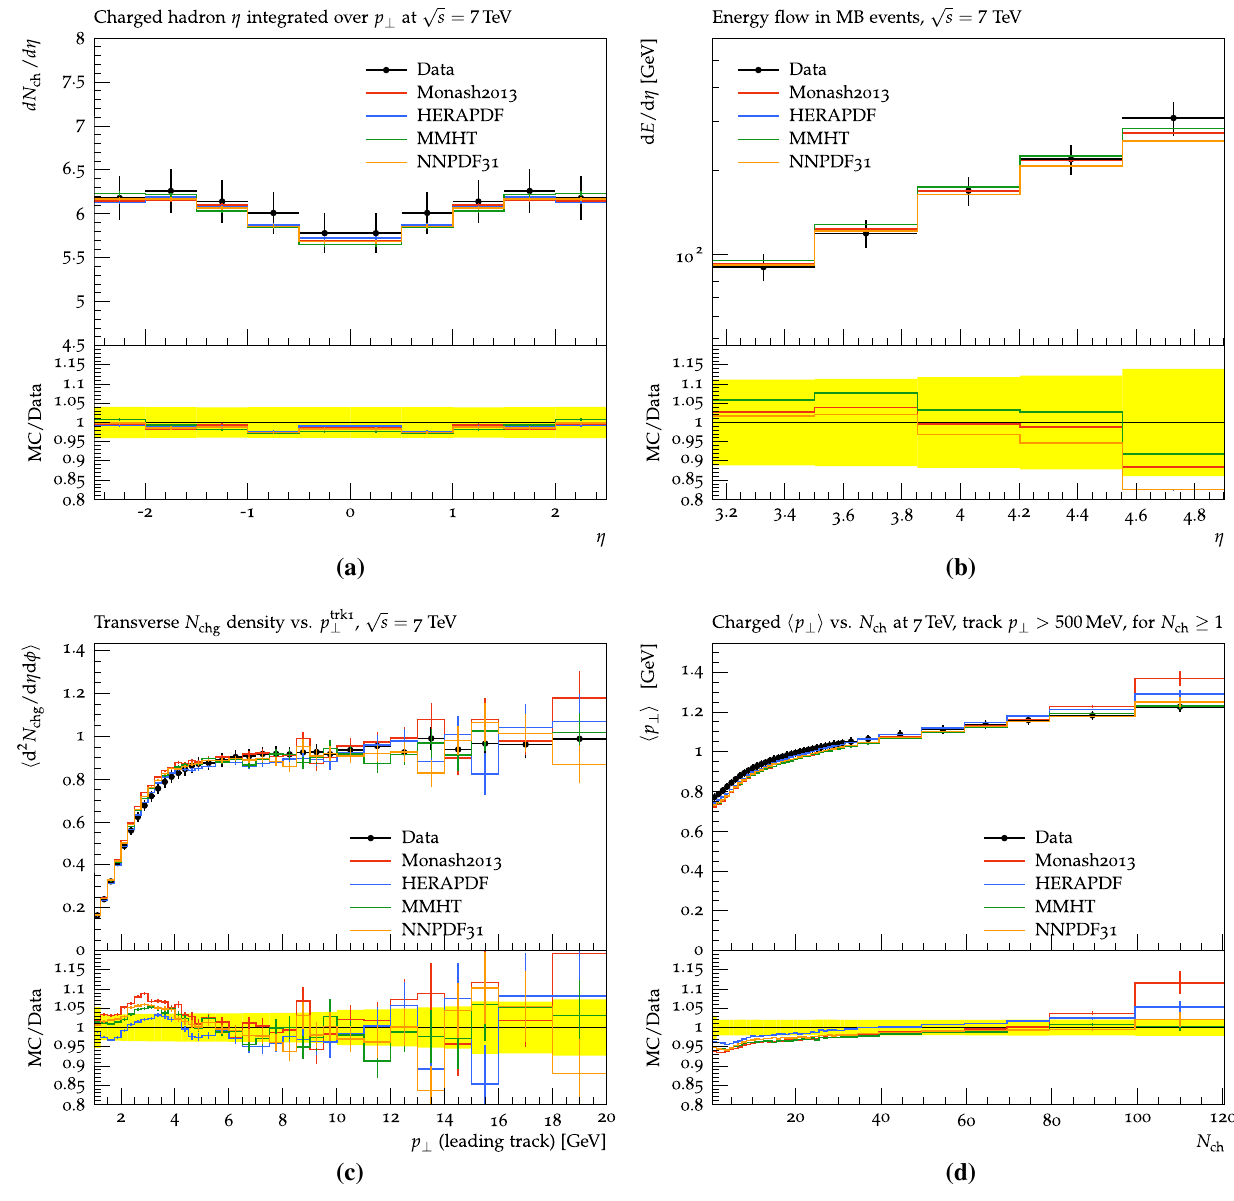
charged tracks as a function of the transverse momentum of the hard- est track as measured by [53] is shown in c. The average transverse momentum of charged tracks as a function of the number of charged tracks measured by ATLAS [54] is shown in d. Plots were produced using Rivet